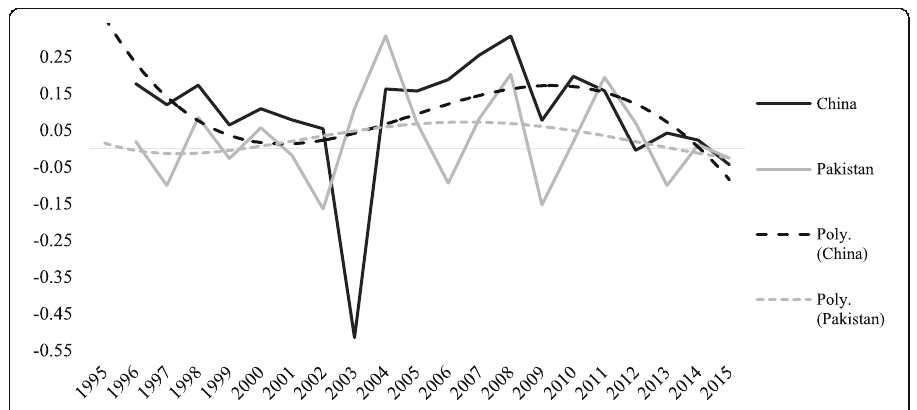
Fig. 3 Growth of labor productivity: value added